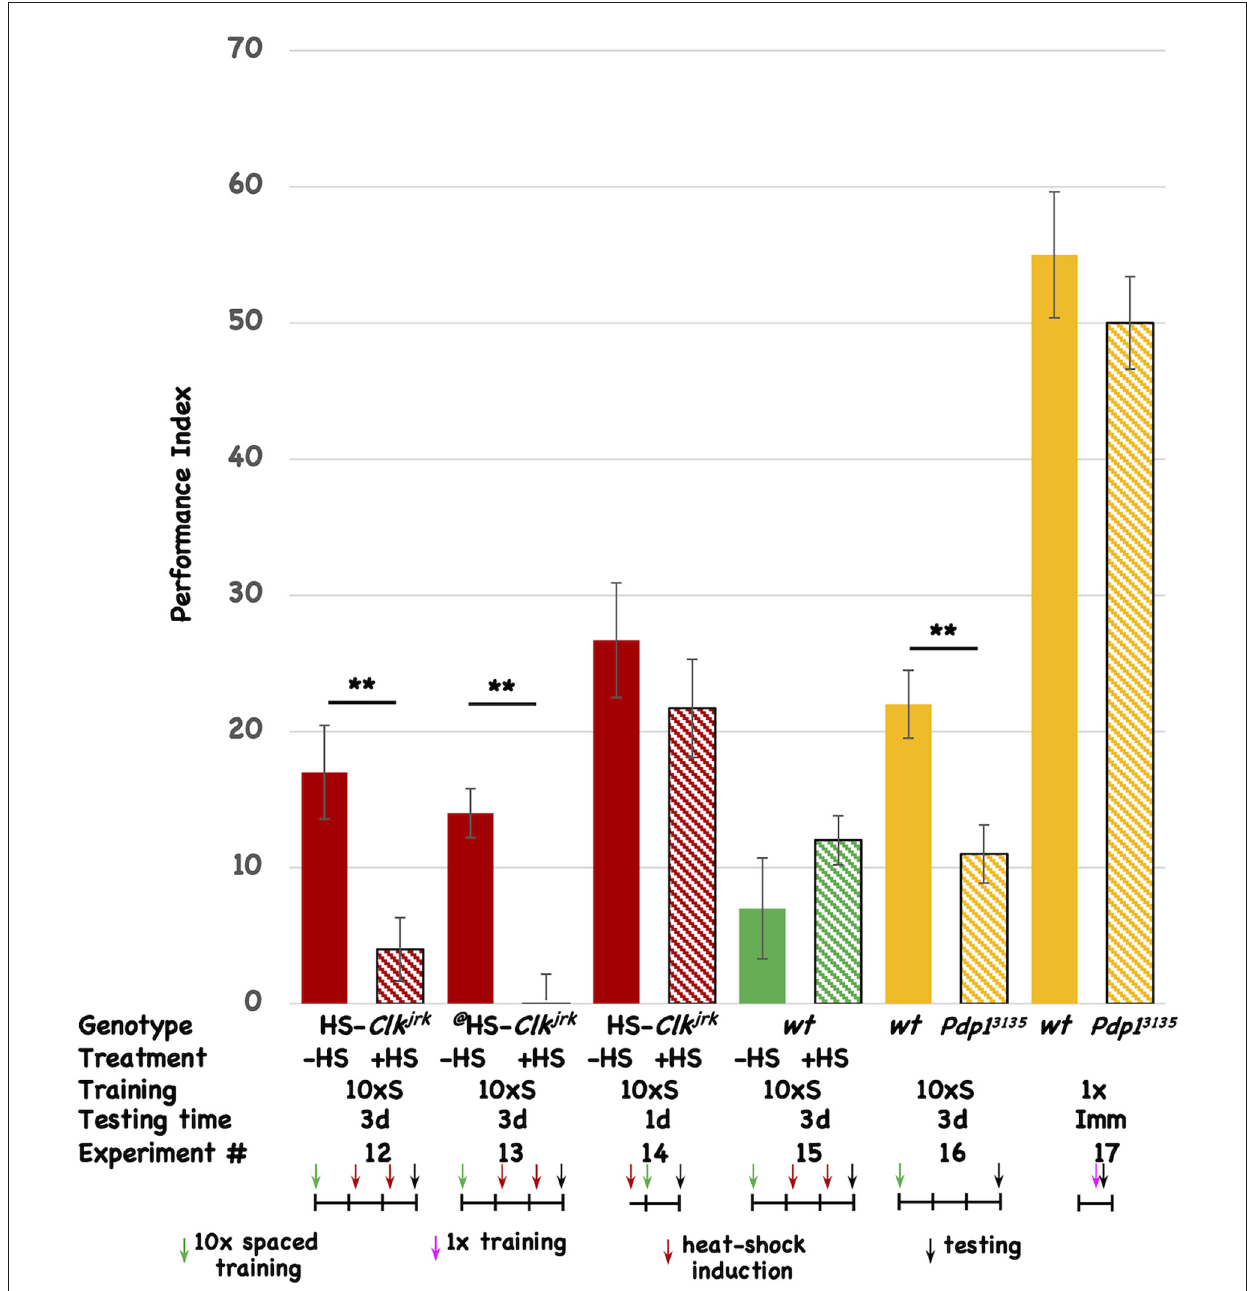
FIGURE3 Disruption of other circadian genes also interferes with 3d memory. The performance of flies is plotted as a function of genotype, treatment, type of behavioral training, and testing time. Colored histograms (solid or striped) show the performance of HS- Clk jrk (red), w 1118 (green), or iso 31 (wt), and the Pdp1 (cid:101) 3135 mutation (orange) that resides in the iso 31 background. The @ symbol denotes a second, independent insertion of the HS- Clk jrk transgene. Solid colors represent the performance of uninduced (red and green) or wild type (orange; iso 31 ) stocks. Striped histograms show the performance of the induced (red and green) or mutant lines (orange stripes). In the table, the last line is the Experiment #. The genotypes are shown in the top line, followed by whether heat-shock (+) or not was given to the flies. 10 × S corresponds to 10 cycles of spaced training, and 1x indicates flies that received only a single training trial. The testing times were immediate (Imm), 1d, or 3d after the end of training. The horizontal line in the cartoon shows the experimental timeline, and each vertical tick mark represents 1d of elapsed time. Green and magenta arrows indicate whether flies received 10 cycles of spaced training or a single cycle of training. The red arrows show the timing of a heat-shock induction (20 ◦ C to 36 ◦ C shift for 30’ duration), while the black arrows indicate the time of testing. The color scheme used for the data histograms (top of Figure) is unrelated